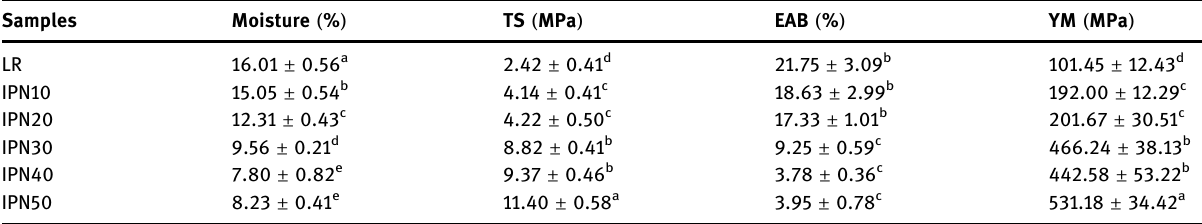
Table 2: Moisture, TS, EAB, and YM of LR and IPN fi lms